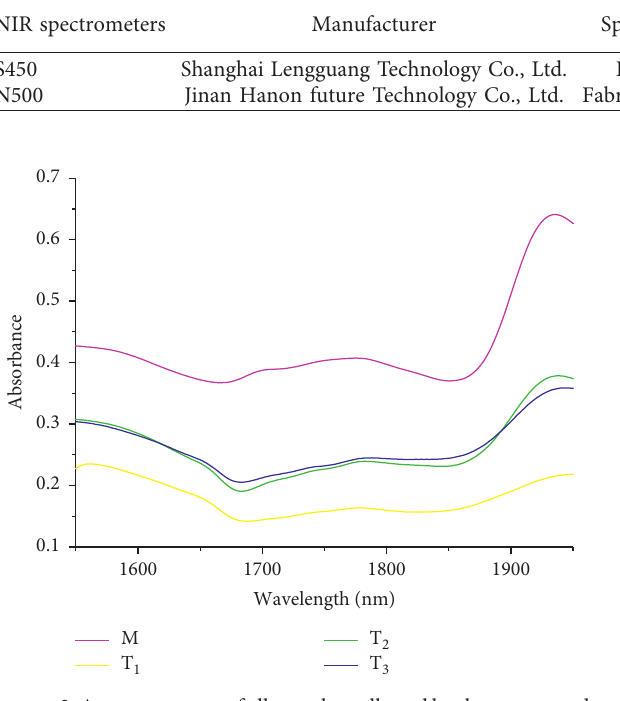
Figure 2: Average spectra of all samples collected by the master and target